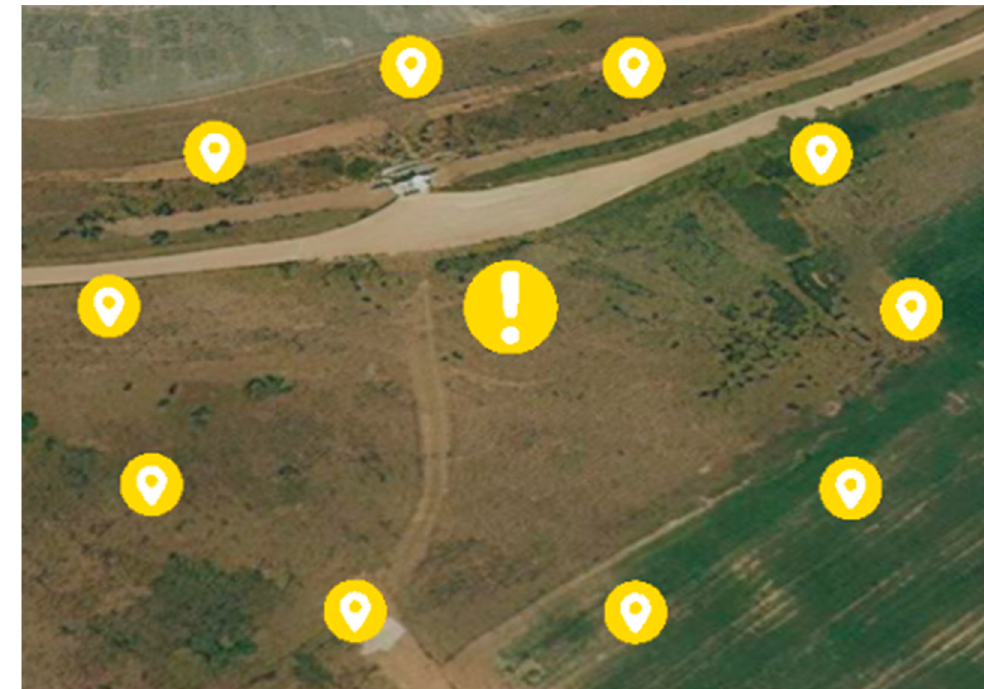
Figure 12. A detail of the points of the on-site mission as shown on the platform.